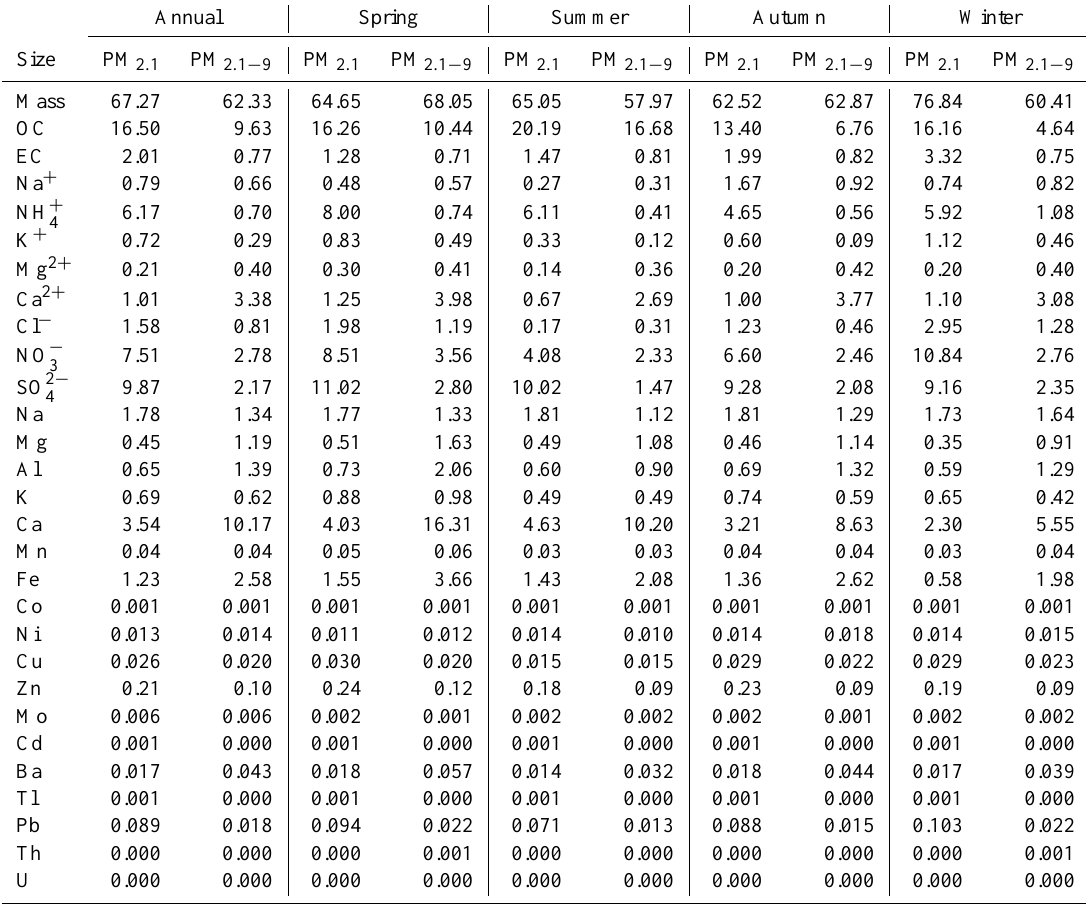
Table 1. Concentrations of different chemical compositions in size-resolved particles during entire sampling period (annual) and four seasons (µgm − 3 )